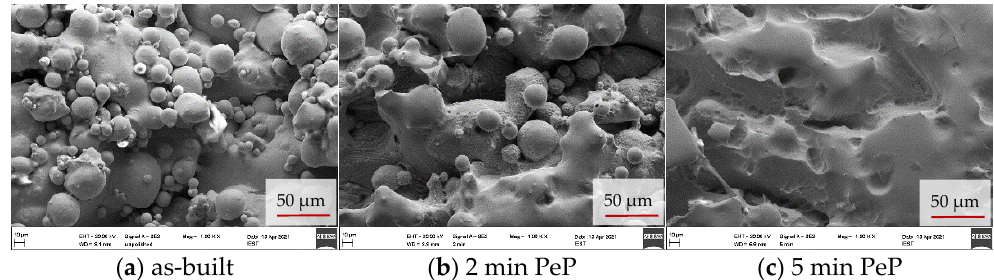
Figure 4. SEM images of the lateral spring surface, revealing the removal of powder adhesions during PeP.